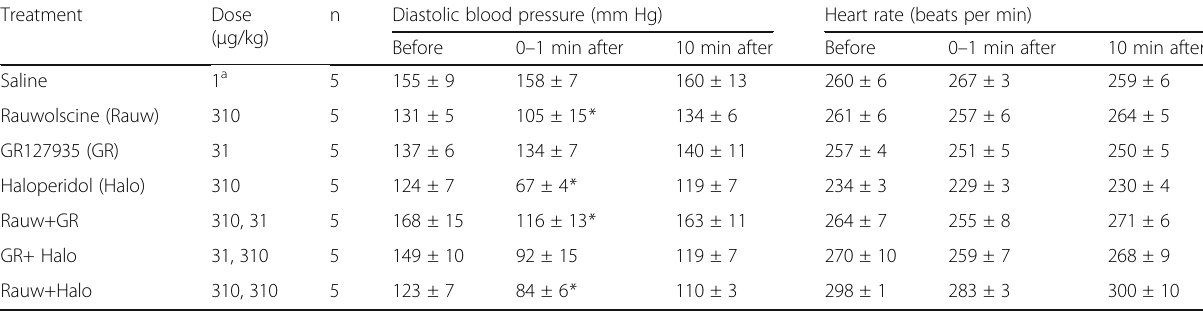
Table 2 Values of diastolic blood pressure and heart rate during the infusion of methoxamine (20 μ g/kg·min): (i) before; (ii) immediately after (within 0 – 1 min after antagonist administration); and (iii) 10 min after i.v. administration of saline, rauwolscine, GR127935 and haloperidol given separately, as well as their respective combinations Treatment Dose n Diastolic blood pressure (mm ( μ g/kg)